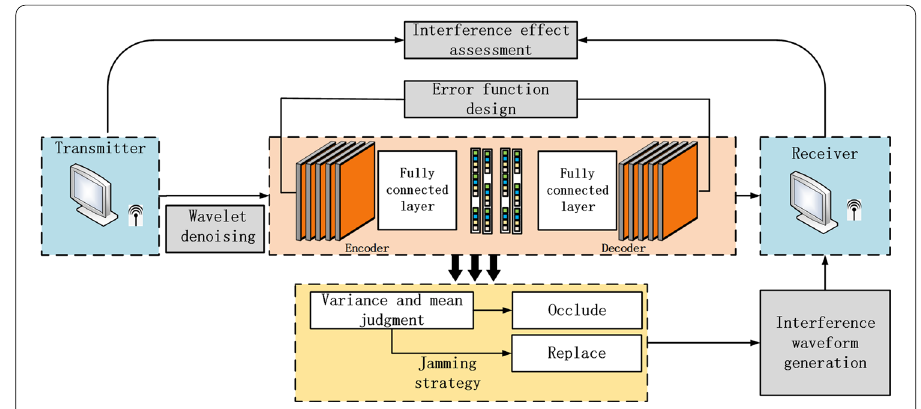
Fig. 1 Interference waveform generation